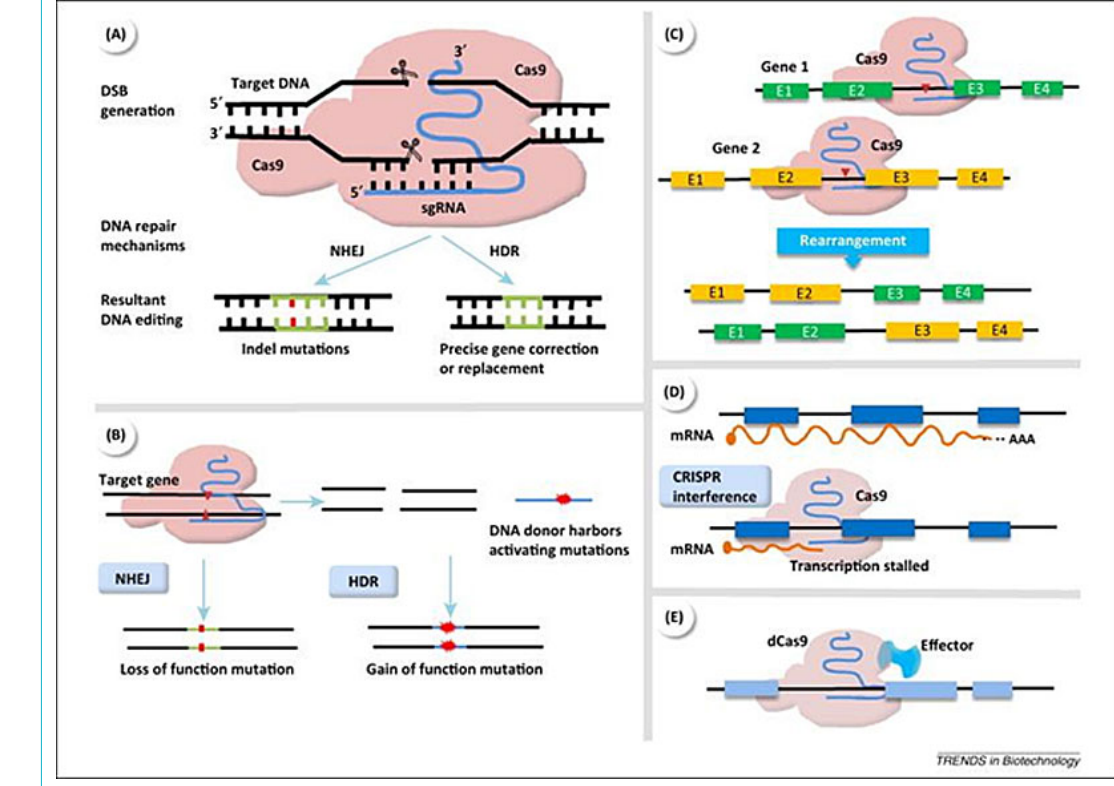
Figure 3: Mechanisms and applications of CRISPR-Cas9 in cancer modelling. (A) Mechanisms of CRISPR-Cas9-mediated genome editing. Cas9 locates and cuts the target sequence directed by the base-pairing between the sgRNA and the target sequence in the presence of a pro- to-spacer-adjacent motif (PAM) on the opposite strand. The resulting DSBs stimulate DNA repair processes, including error-prone NHEJ that induces indel mutations, and HDR that leads to precise gene repair or replacement. The yellow line indicates the PAM. Green lines indicate re- paired DNA sequence, while the short red lines indicate indel mutations generated by NHEJ. (B) Schematic of CRISPR-Cas9 induced loss or gain-of-functions mutations. Left: NHEJ mediates loss-of-function indel mutations. Right: In the presence of a donor template, activating muta- tions in the template are introduced into the target gene via homologous recombination. (C) CRISPR-Cas9 mediated chromosomal rearrange- ment. (D) CRISPR interference: Cas9 binding to DNA sequence per se exerts transcriptional suppressive effects. (E) dCas9 is repurposed as a site-specific DNA-binding domain that transports various effectors to the target loci. Abbreviations: Cas9, CRISPR-associated 9; CRISPR, clustered regularly interspaced short palindromic repeats; dCas9, dead Cas9 (catalytically inactivated version of Cas9); DSB, double-strand break; E, exon; HDR, homology-directed repair; NHEJ, non-homologous end-joining; sgRNA, single guide RNA. Reprinted with permission from Lu XJ, Qi X, Zheng DH, Ji LJ. Modeling cancer processes with CRISPR-Cas9. Trends Biotechnol. 2015;33 [6]:317–9. doi: 10.1016/ j.tibtech.2015.03.007